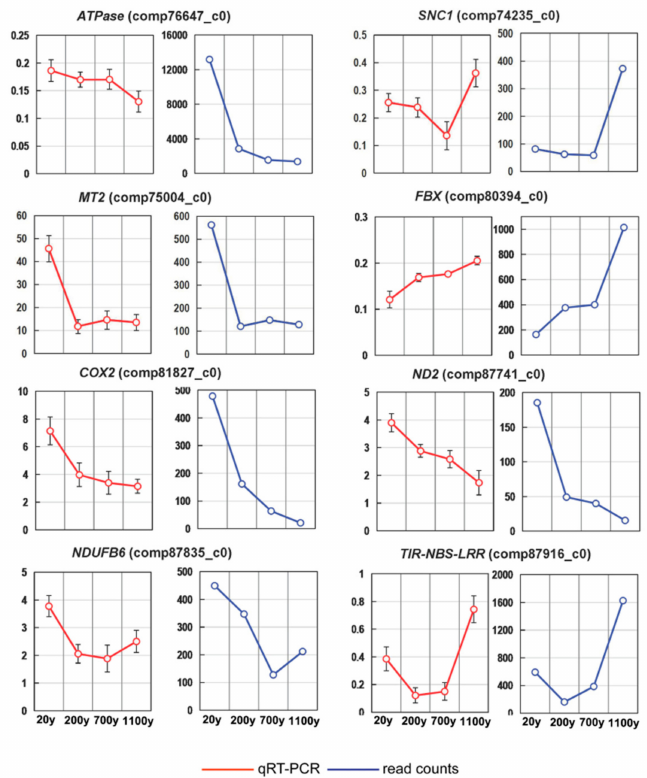
Figure 8. Expression patterns of eight selected unigenes in Platycladus orientalis leaves. Verification of eight selected DEGs by RT-qPCR. The α TUB gene was used as the internal control. Both methods revealed similar gene expression trends. Red and blue lines correspond to the RT-qPCR and RNA-seq results, respectively. Vertical bars represent the mean ± SD of four separate experiments.